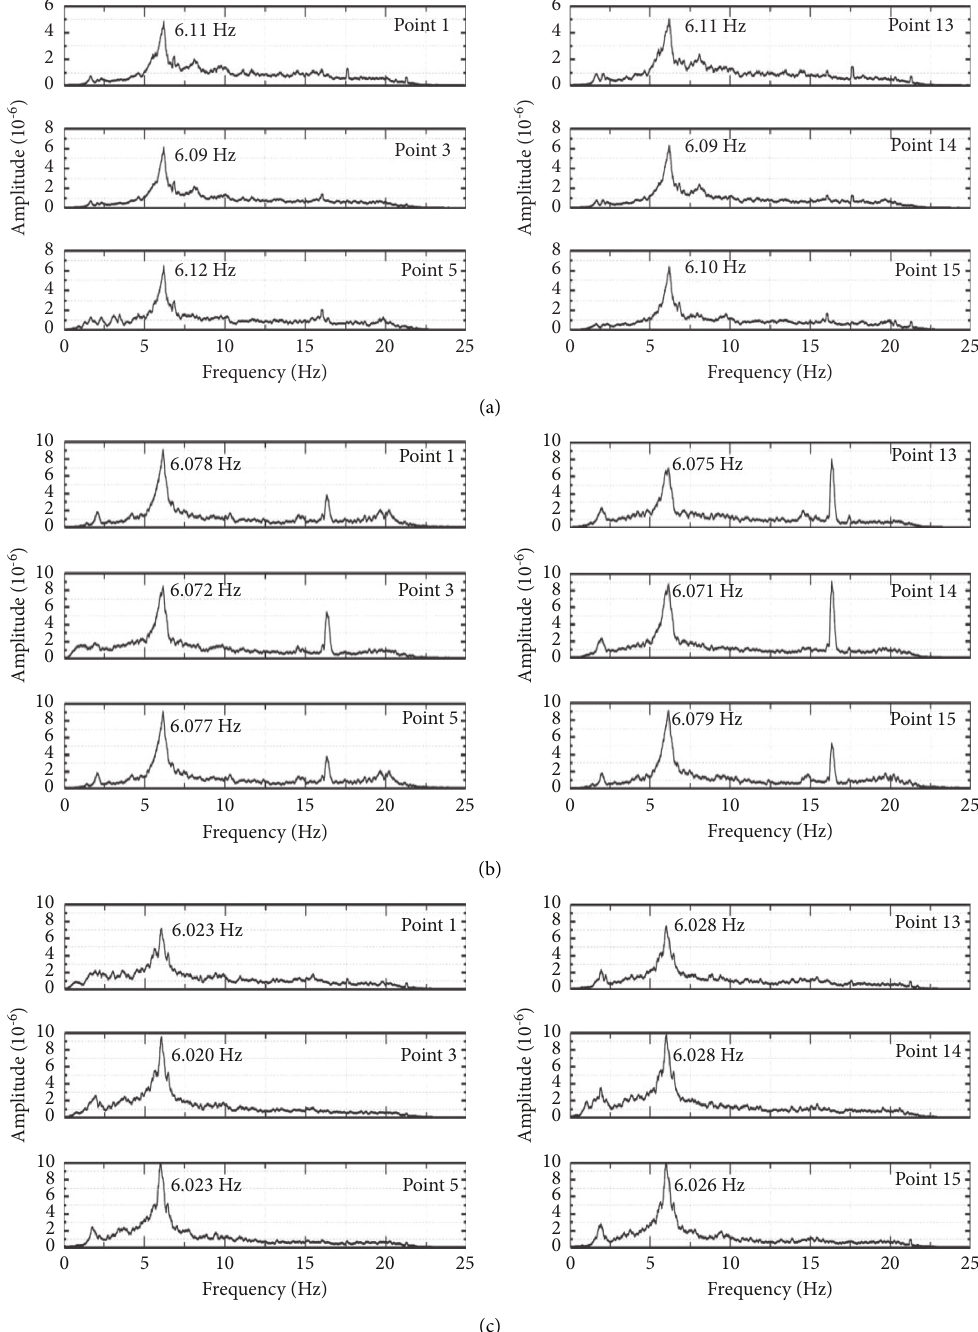
Figure 7: The amplitude-frequency curves of different measuring points. (a) Ambient excitation on the floor. (b) Ambient excitation on the part floor with 24 people. (c) Ambient excitation on the whole floor with 56